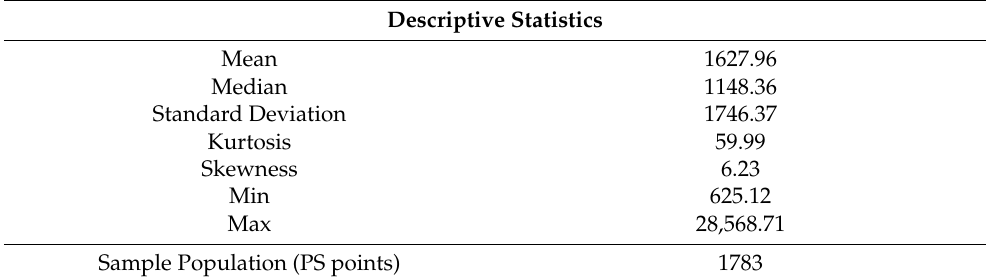
Table 3. Descriptive statistics of radar cross section (RCS) building sample (example based on VV/descending data).